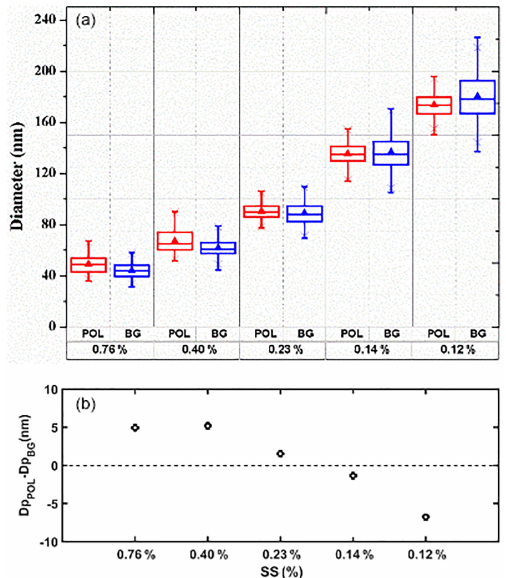
Figure 4. (a) Retrieved mean critical activation diameters at SS = 0.12, 0.14, 0.23, 0.40, and 0.76% under background (BG) and polluted (POL) conditions. The box plots show mean critical activa- tion diameters at the 25th, 50th, and 75th percentiles. (b) Difference in the mean critical activation diameter between BG and POL